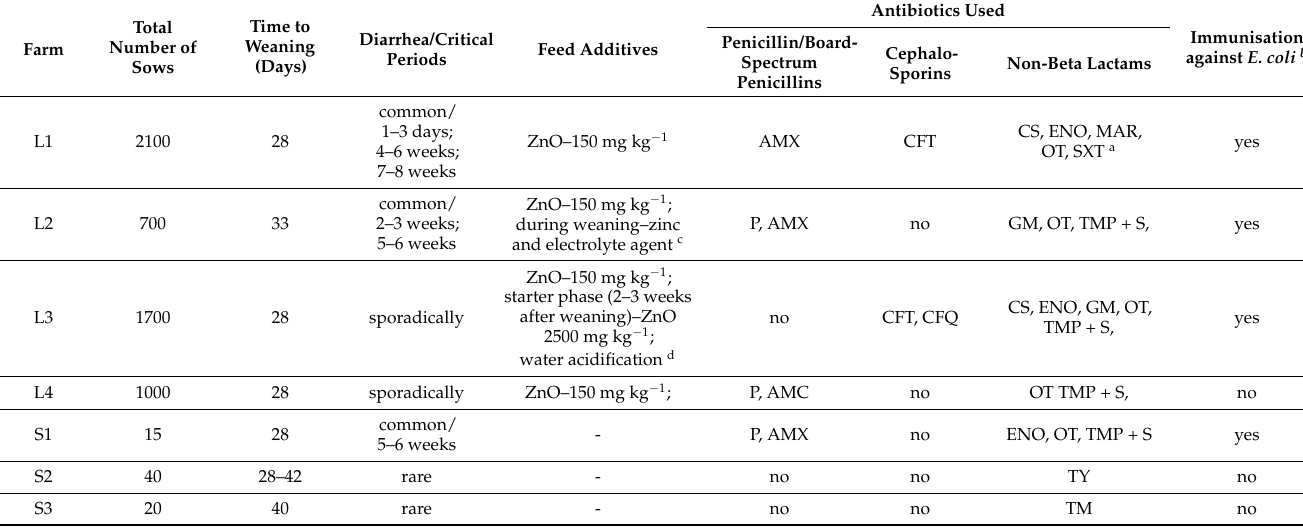
Table 4. Characteristics of farms, prophylaxis and antimicrobial policy. AMX–amoxicillin, AMC–amoxicillin + clavulanic acid, CFT–ceftiofur, CFQ–cefquinome, CS–colistin, ENO–enrofloxacin, GM–gentamicin, OT–oxytetracycline, P–penicillin, MAR–marbofloxacin, TM–tiamulin, TY–tylosin, TMP + S–trimethoprim + sulfadiazine, ZnO–Zinc